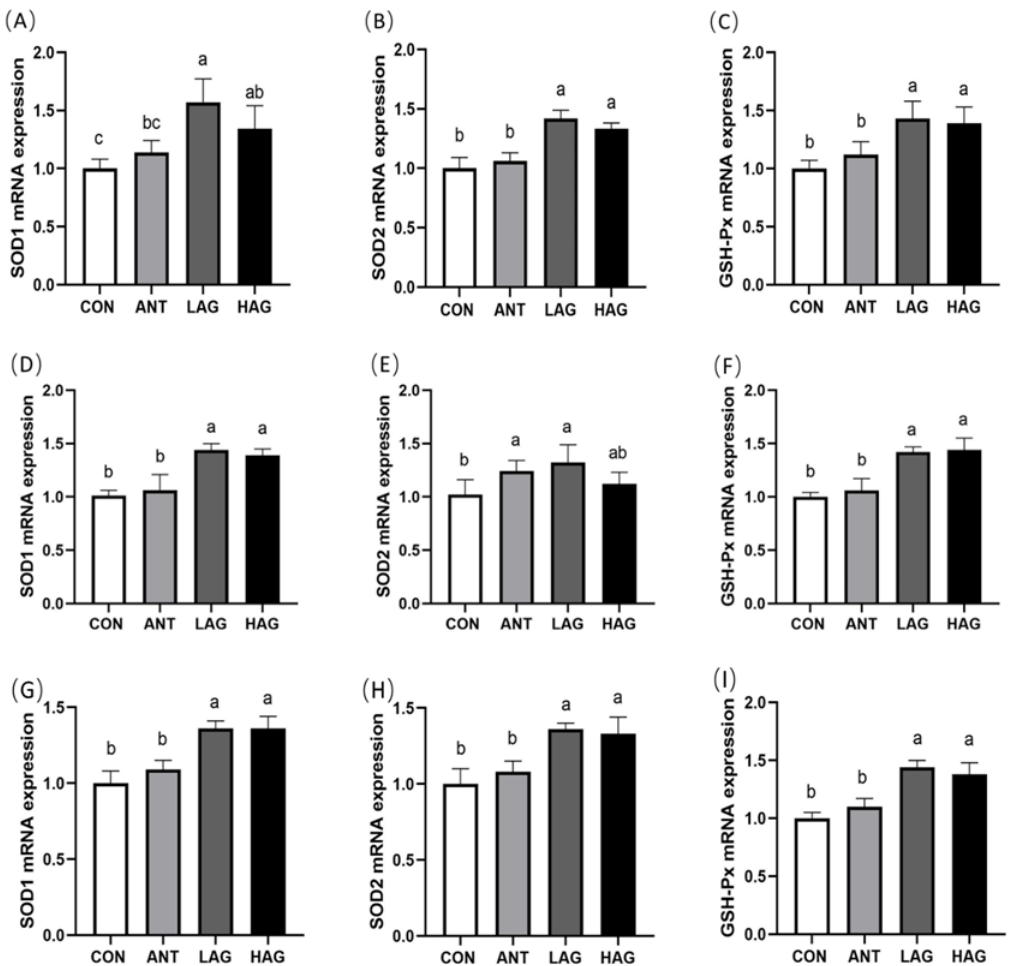
Figure 1. ( A – I ) Effect of Astragalus-Glycyrrhiza polysaccharides on mRNA expression of antioxi- dant enzyme-related in the duodenum, jejunum and ileum of broilers. Data are means ± SEM, n = 6. Means with different letters indicate significant differences ( p < 0.05).